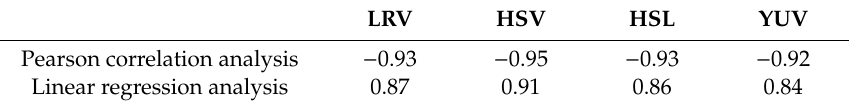
Table 5. Relationship between the color space technique and the surface temperature.